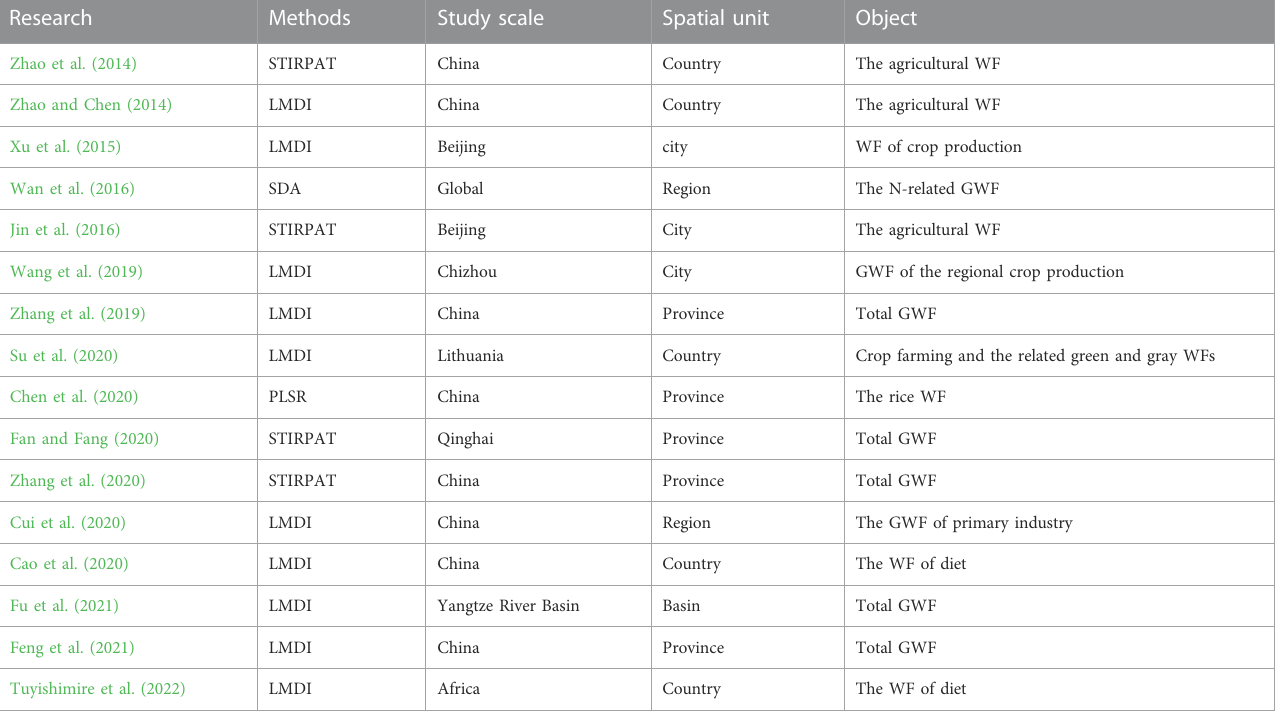
TABLE 1 Summary of representative literature on the driving forces of the gray water